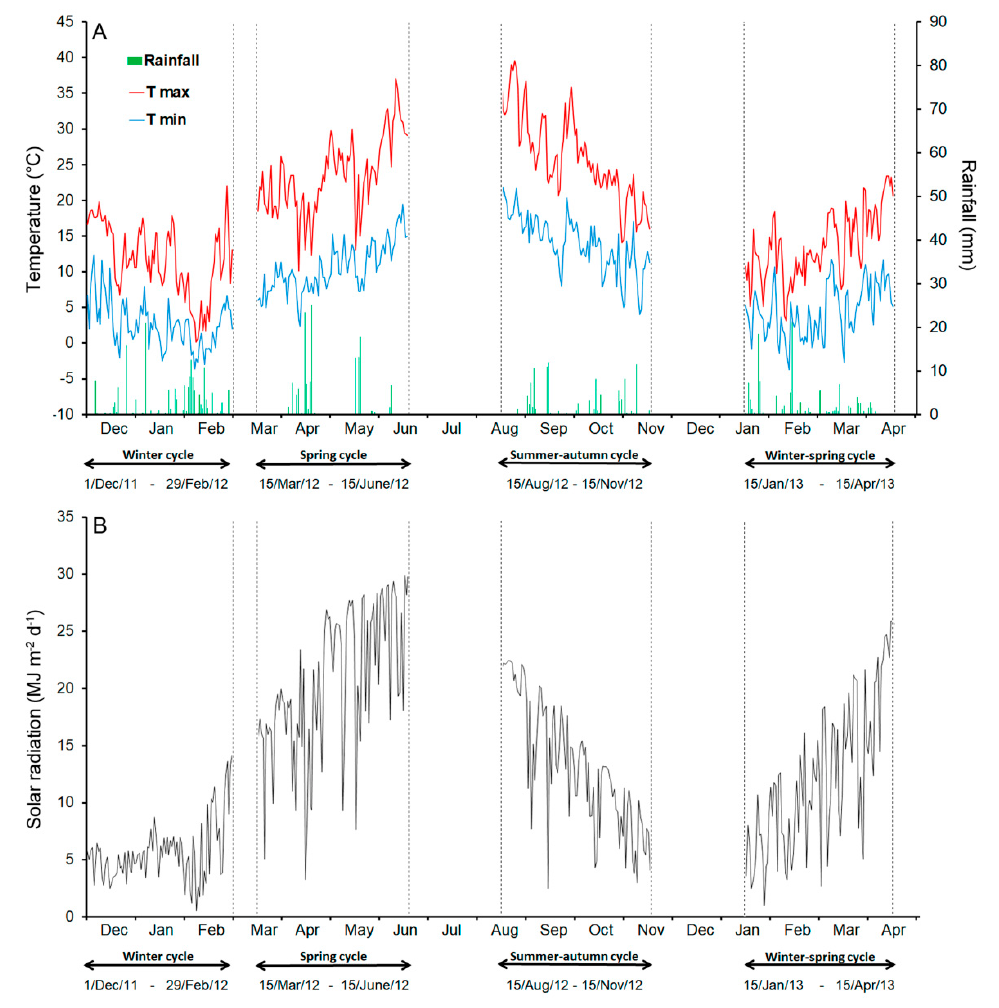
Figure 1. Climatic data during the four growing periods (winter, spring, summer–autumn, and winter–spring) of the broccoli crops: ( A ) the temperatures and rainfall; ( B ) the solar radiation.